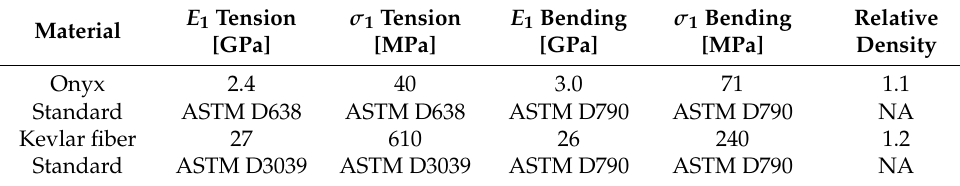
Figure 2. Schematic of fiber layout options and fill patterns in Eiger ® software, [9].